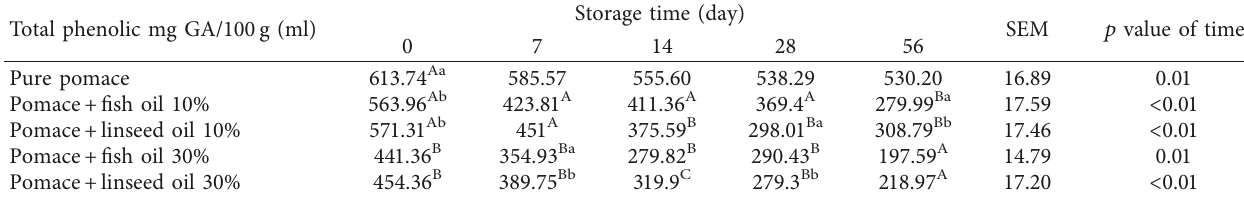
Table 1: The content of total polyphenols in the test formulations during storage (mg GA/100g). Total phenolic mg GA/100 g (ml)